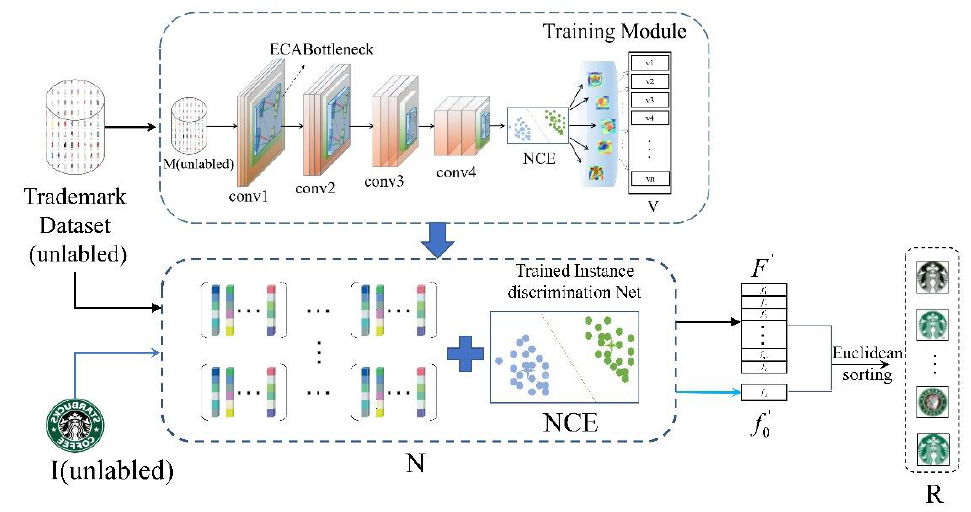
Figure 2. Unsupervised trademark retrieval method with embedded attention